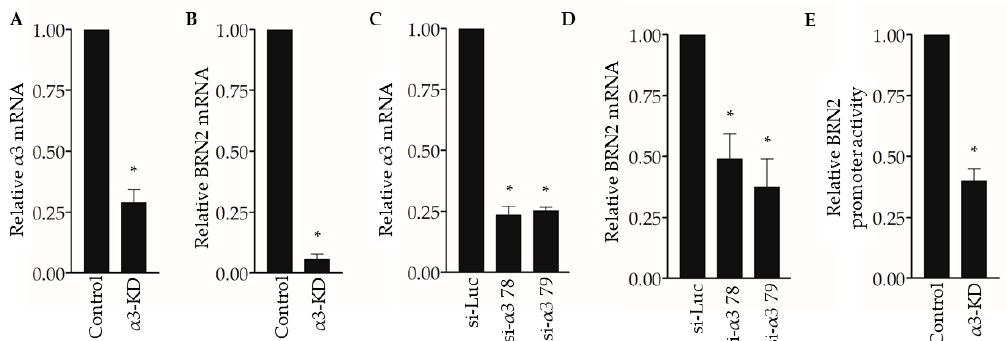
Figure 2. Suppression of integrin α 3 β 1 decreases BRN2 mRNA and promoter activity in MDA-MB-231 cells. ( A , B ) qPCR showing ( A ) relative integrin α 3 and ( B ) BRN2 mRNA levels in MDA-MB-231 cells stably transduced with α 3-targeting shRNA ( α 3-KD), relative to control cells that express non-targeting shRNA (Control). ( C , D ) qPCR showing ( C ) integrin α 3 and ( D ) BRN2 mRNA levels in MDA-MB-231 cells transfected with siRNA that targets integrin α 3 (si- α 3 78 or si- α 3 79) relative to cells transfected with control siRNA (si-Luc). ( E ) BRN2 promoter/luciferase reporter activity in α 3-KD cells relative to control cells. n = 3; mean +/ − SEM; * p < 0.05; two-tailed T -test ( A , B , E ) or two-tailed T -test with Bonferroni correction ( C , D ).